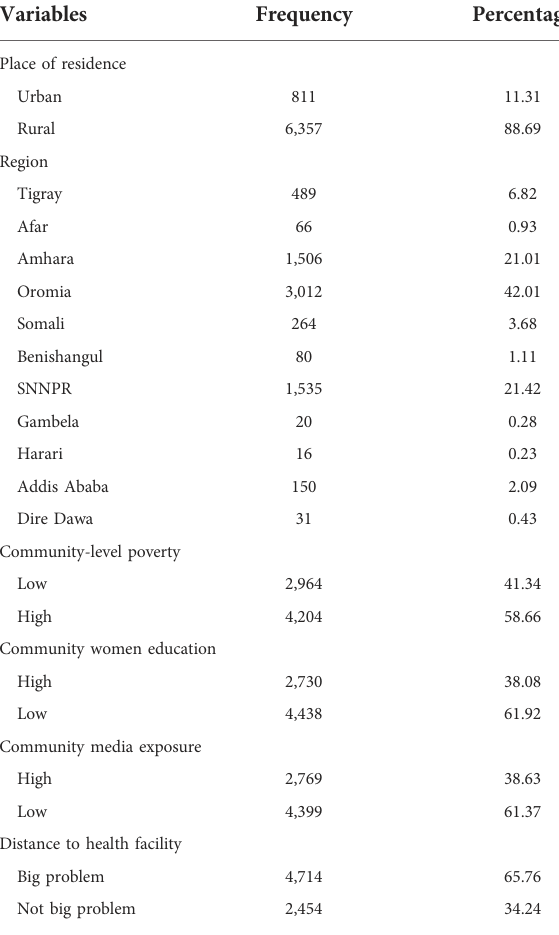
TABLE 3 Distribution of both actually collected and aggregated community level variables of the study, EDHS (2016) ( N =7,168).